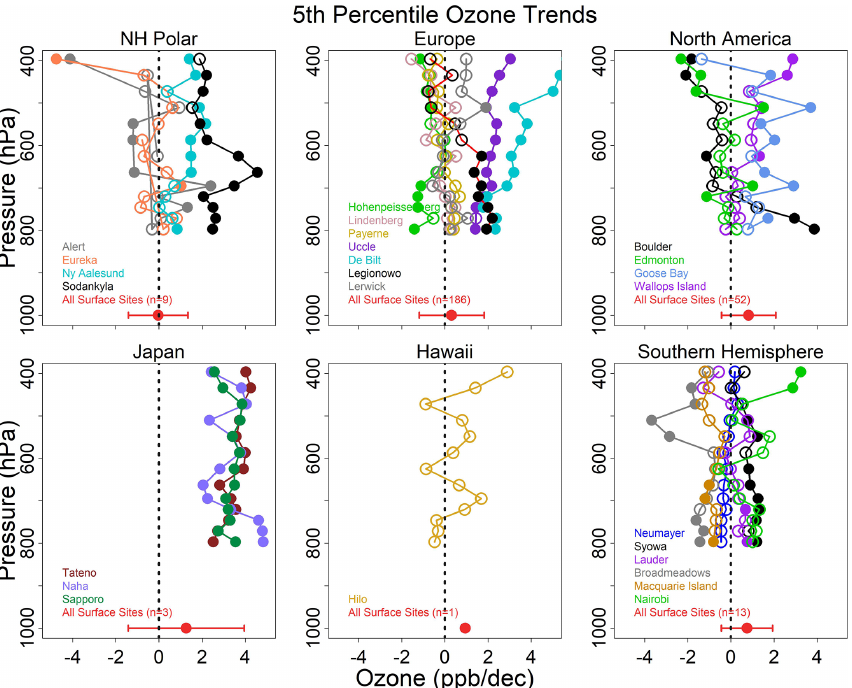
Figure 6. Trends in 5th percentile ozone (ppb per decade through the free troposphere (800–400hPa) at the 25 global ozonesonde sites (1990–2017) and mean 5th percentile ozone trends at the surface for all 238 sites within the six designated regions (1990–2014). Solid circles indicate that the trends are statistically significant ( p < 0 . 1), while open circles are statistically insignificant. Error bars for surface background sites represents the standard deviation across all